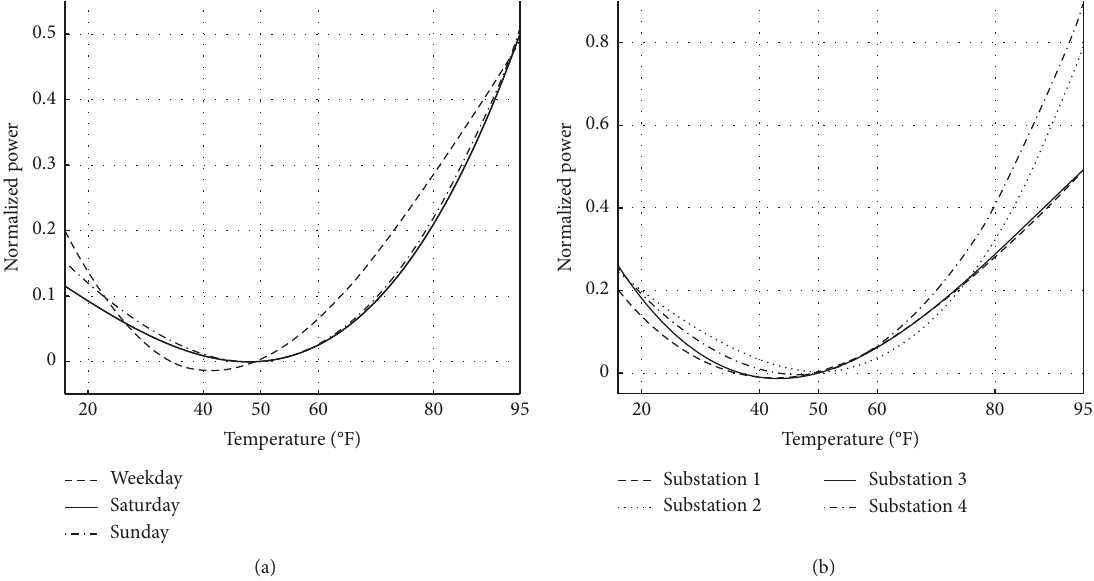
Figure 7: Normalized power-temperature curve of different network substations at 2 PM (power normalized based on 50 ° F): (a) curves for different day types of one substation; (b) curve for 4 substations of weekday.